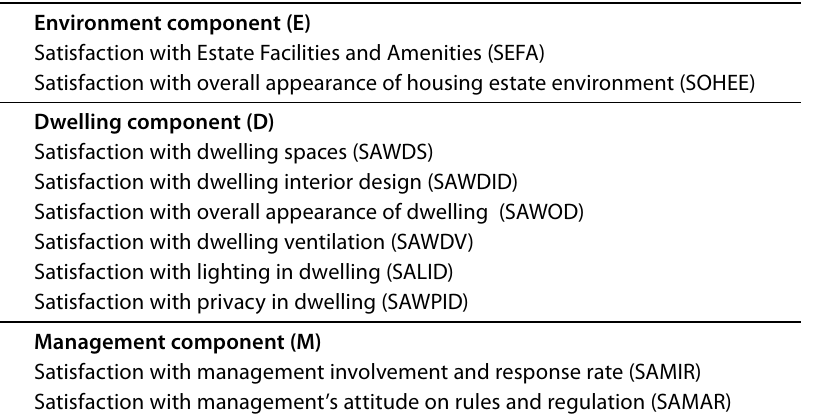
Table 1. housing samples for questionnaire administration S/No Category of housing estates i